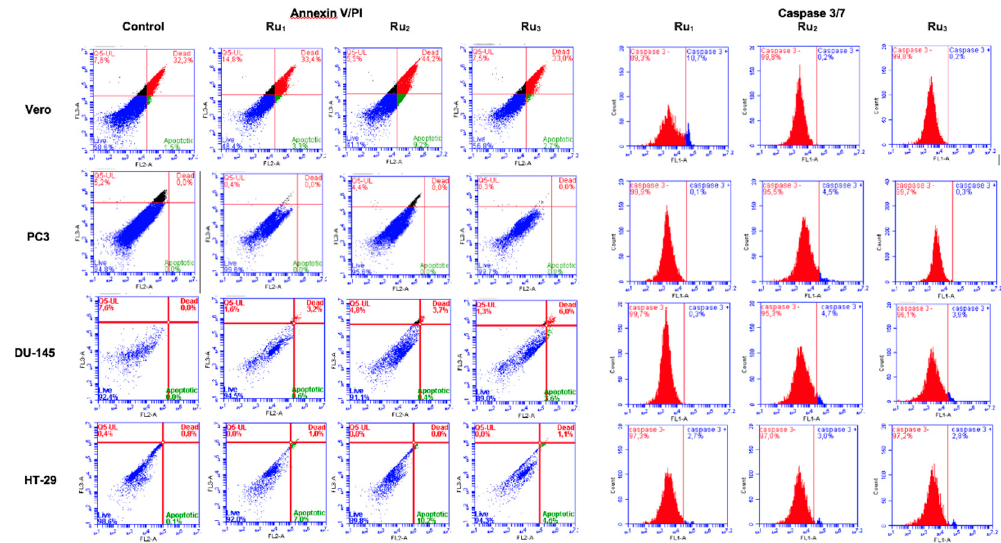
Figure 3. Representative flow cytometry dot plots show the Annexin V and Caspase 3/7 after Ru complexes incubation.